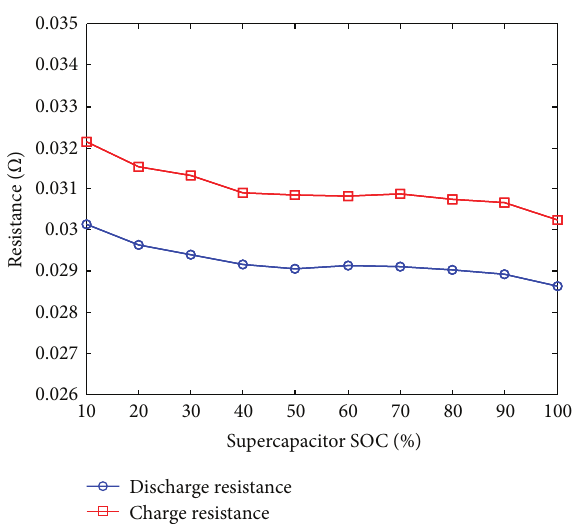
Figure 30: Charging/discharging internal resistances of the super- capacitor